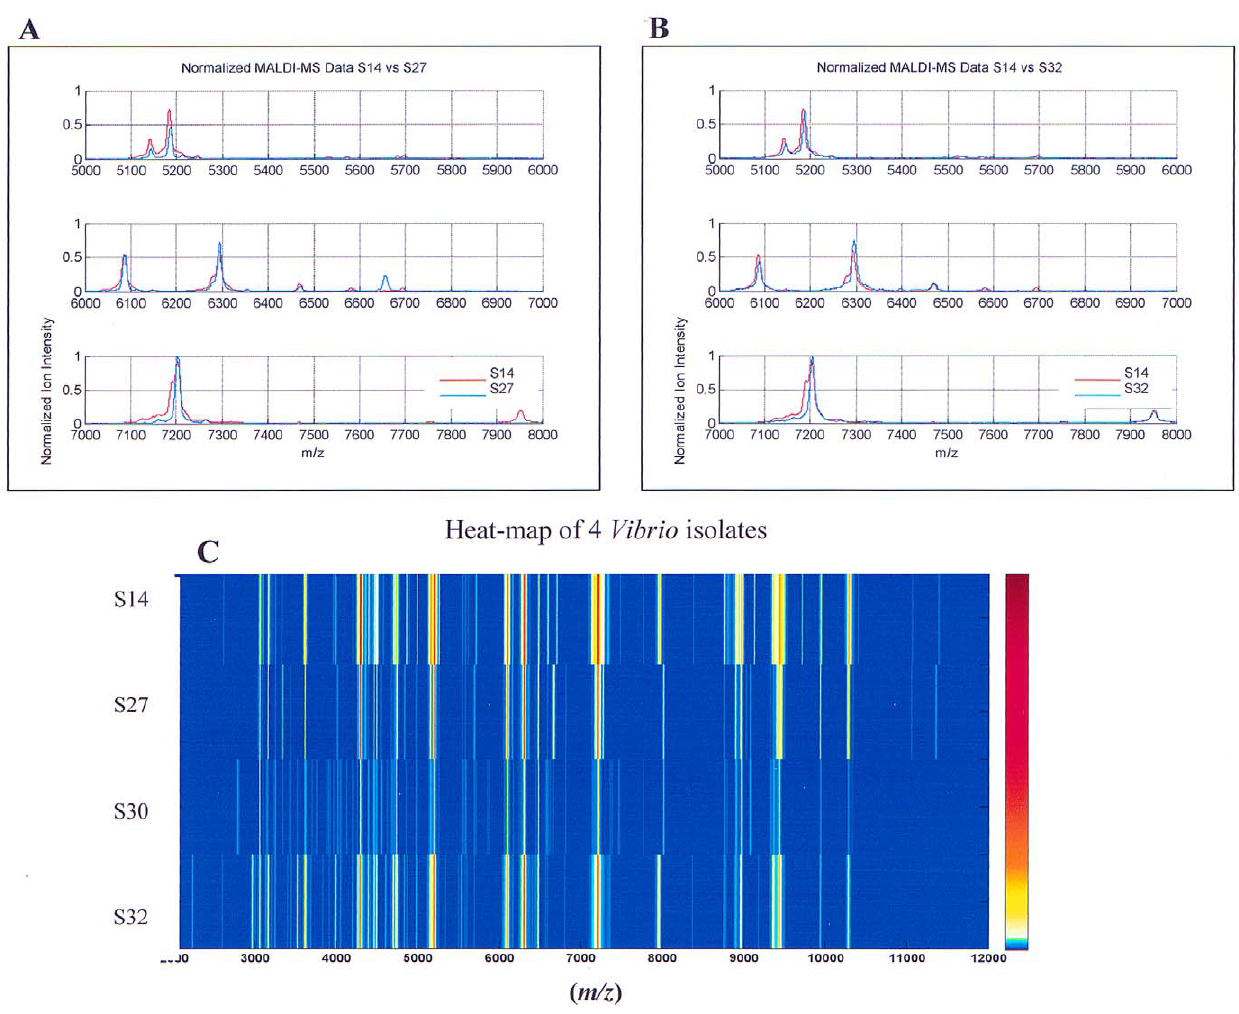
Figure 9. Examples of in-house CCV analysis of Vibrio isolates S14 and S27 (A) and S14 and S32 (B). Panel C shows the spectrograms of Vibrio isolates S14, S27, S30, and S32.